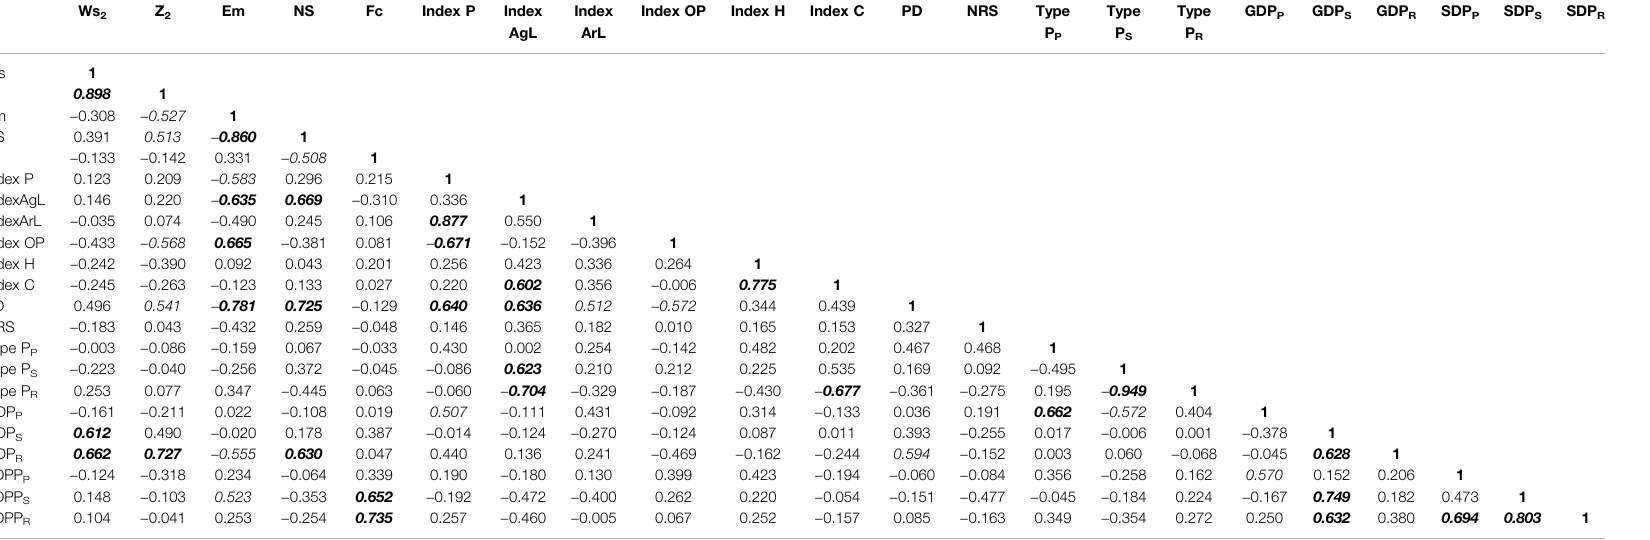
TABLE 7 | Correlation matrix of Principal component analysis [Pearson